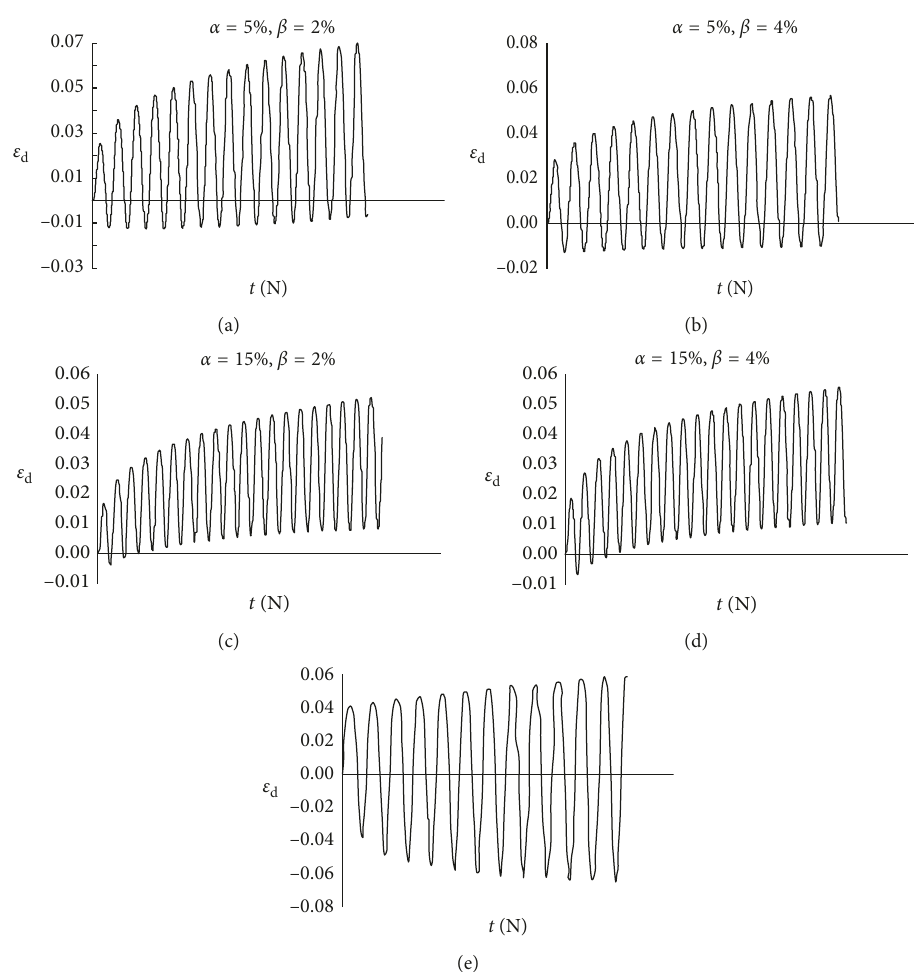
Figure 4: Typical dynamic strain time history character curves of LCES. (a) T11, (b) T13, (c) T31, (d) T33, and (e) T00 (material clay).